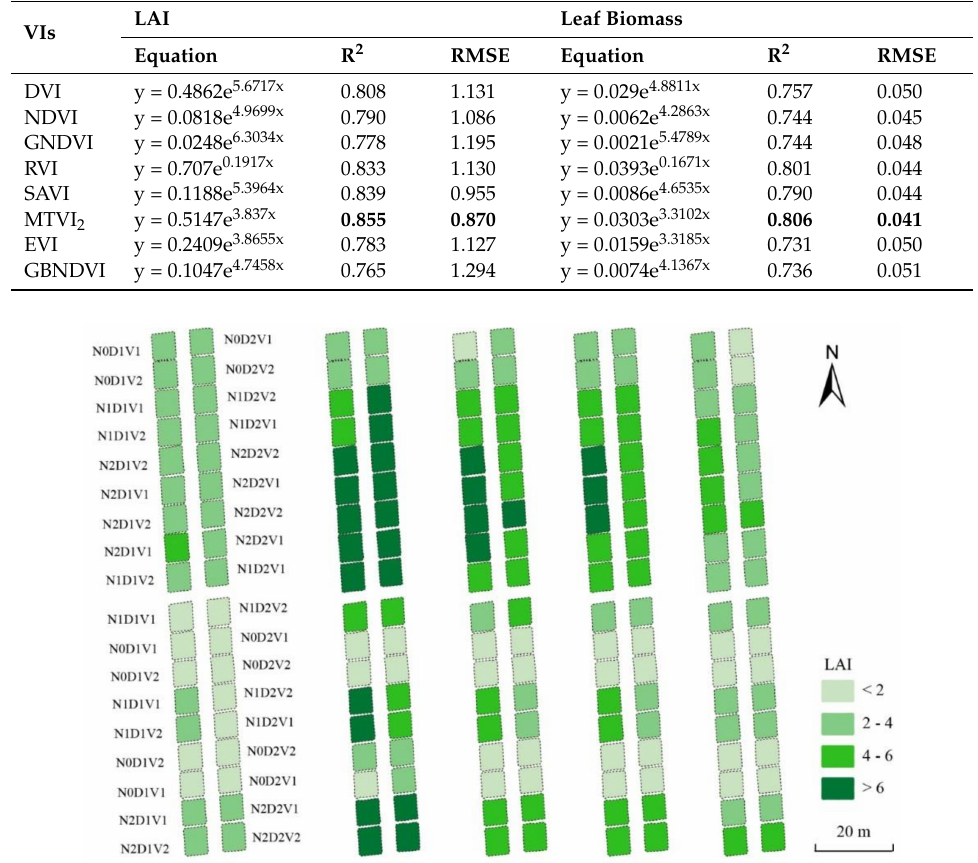
Table 8. Statistical assessments for the estimation of leaf area index (LAI) and leaf biomass with vegetation indices (VIs) for the Mini-MCA6 images. R 2 is the determination coefficient, and RMSE is the root-mean-square error. Values in bold indicate the best accuracy (column basis).